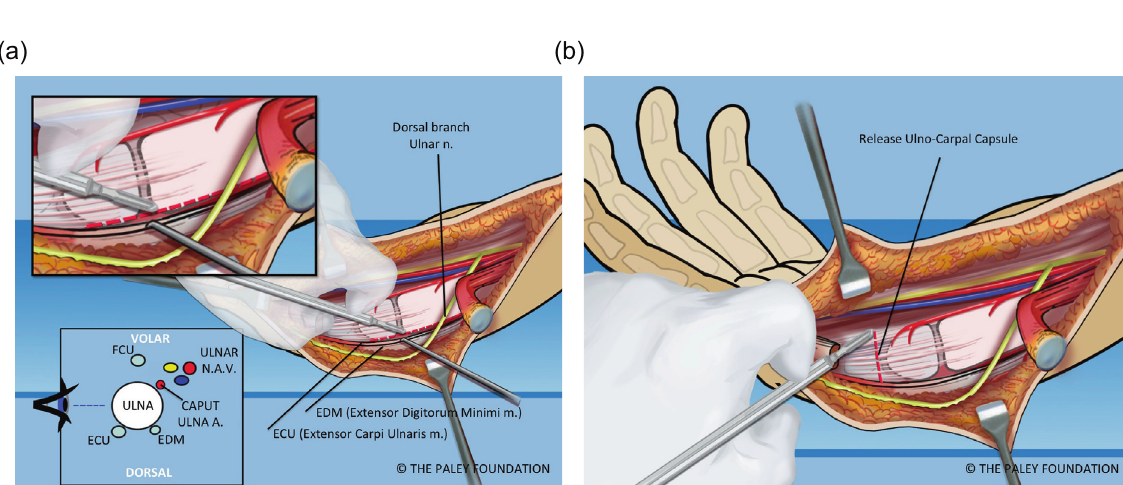
Figure 6. The ulna is dissected free of the ECU and EDM on its ulno-dorsal aspect (a). The ulnar collateral ligament and capsule are cut (b). The caput ulnar vessels lie on the volar radial aspect of the ulna.